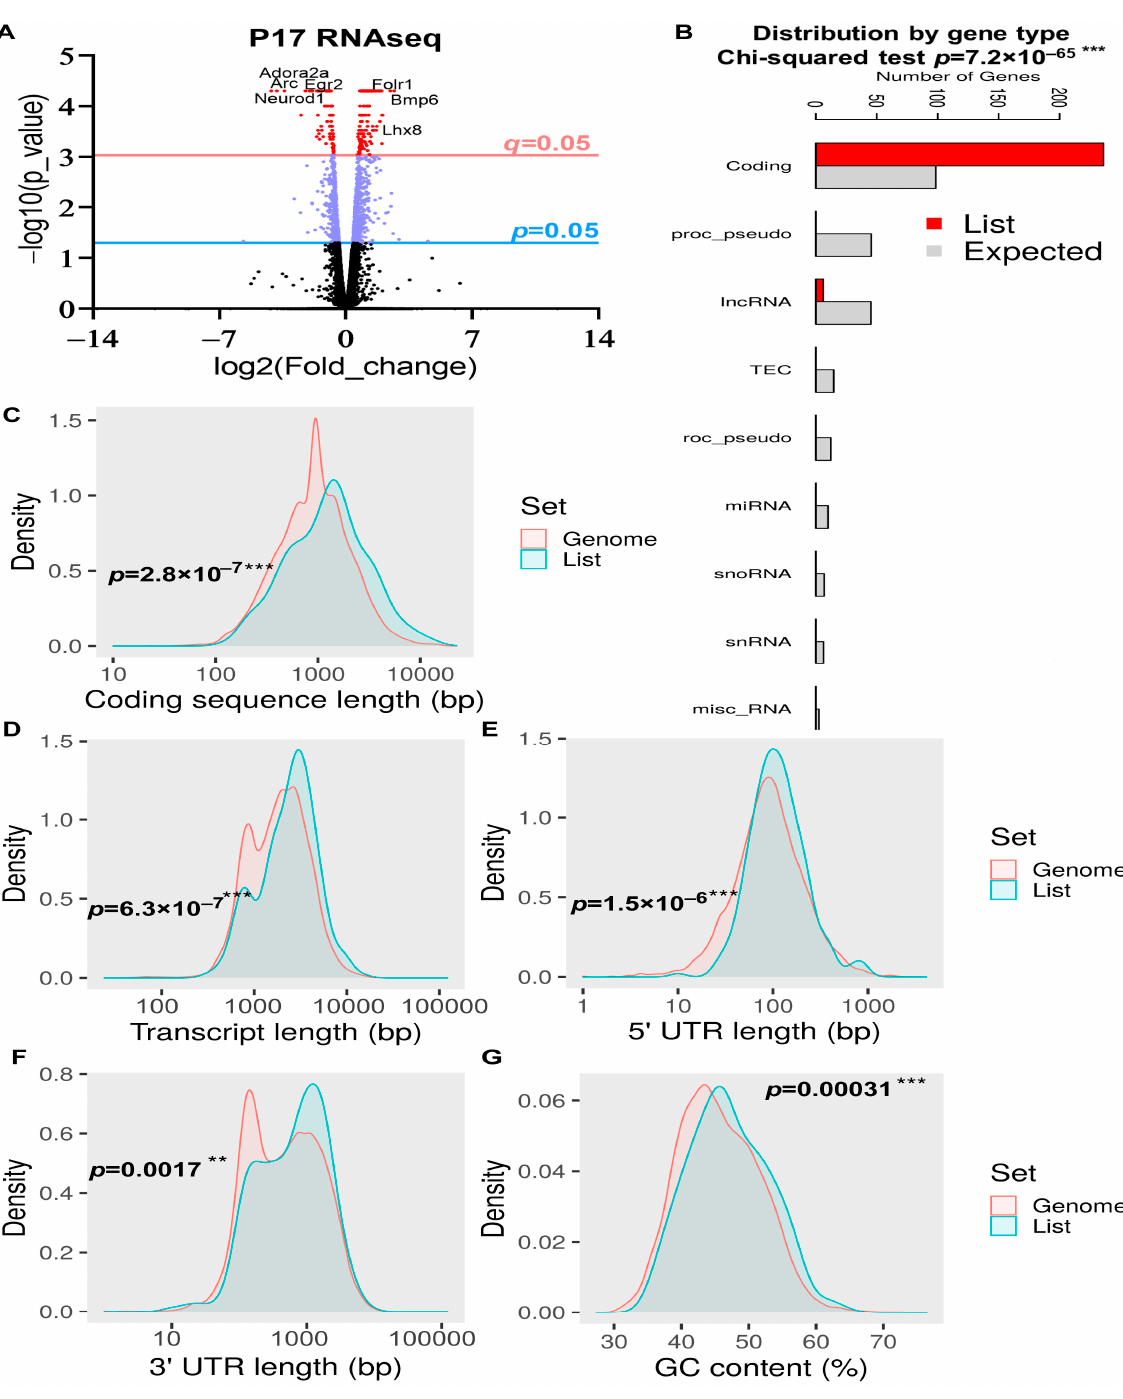
Figure 2. Quantifiable expressional changes in a whole-brain comparison between control and Rbm8a cKO mice at P17. ( A ) The volcano plot of all transcripts detected in the brains of control and Rbm8a cKO mice at P17. A total of 1227 genes were expressed differently with p < 0.05, 597 genes were expressed differently with p < 0.01, and 251 genes were expressed differently with q < 0.05. A total of 140 DEGs with significant q -values were up- or downregulated at least twofold. The p and q cutoffs = 0.05 are shown. ( B ) The distribution of DEGs is significantly enriched in the protein-coding genes. ( C – G ) DEGs at P17 show significant changes in coding sequence length ( C ), transcript length ( D ), 5 (cid:48) UTR length ( E ), 3 (cid:48) UTR length ( F ), and GC content ( G ) when compared with the general genome. **, p < 0.01; ***, p < 0.001 for ( B – G